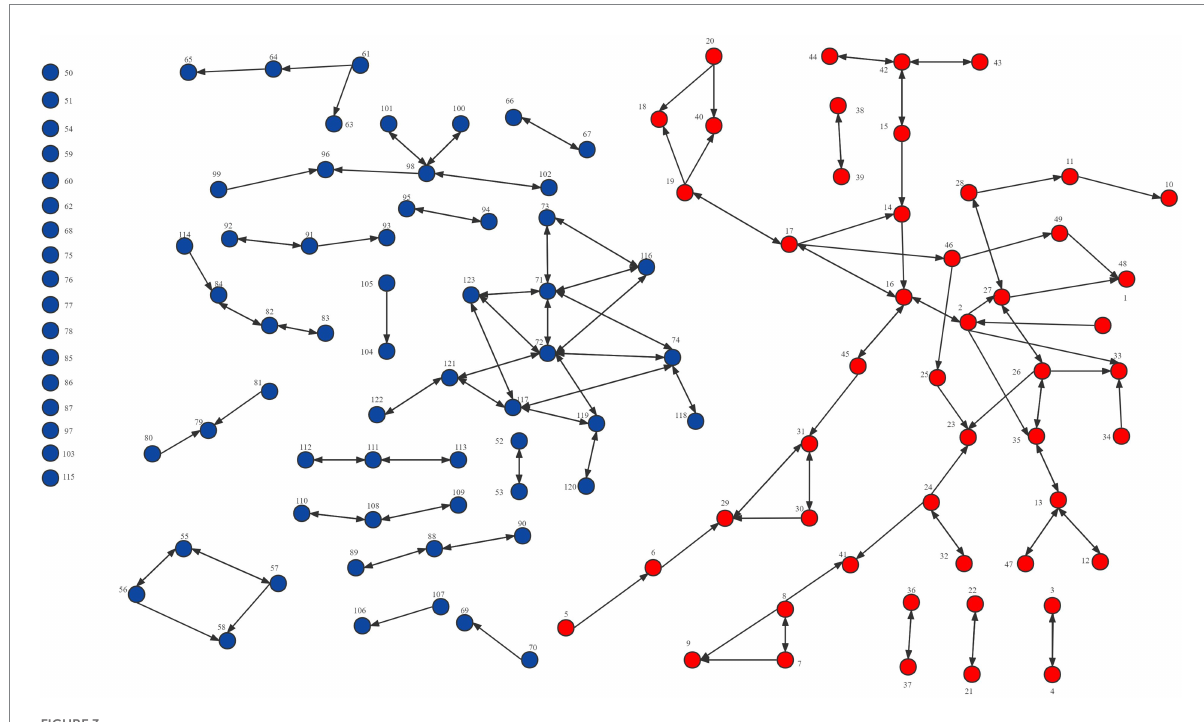
FIGURE 3 Network visualization of the intra-organizational knowledge sharing network for health technology in the Fujian liver disease specialist medical